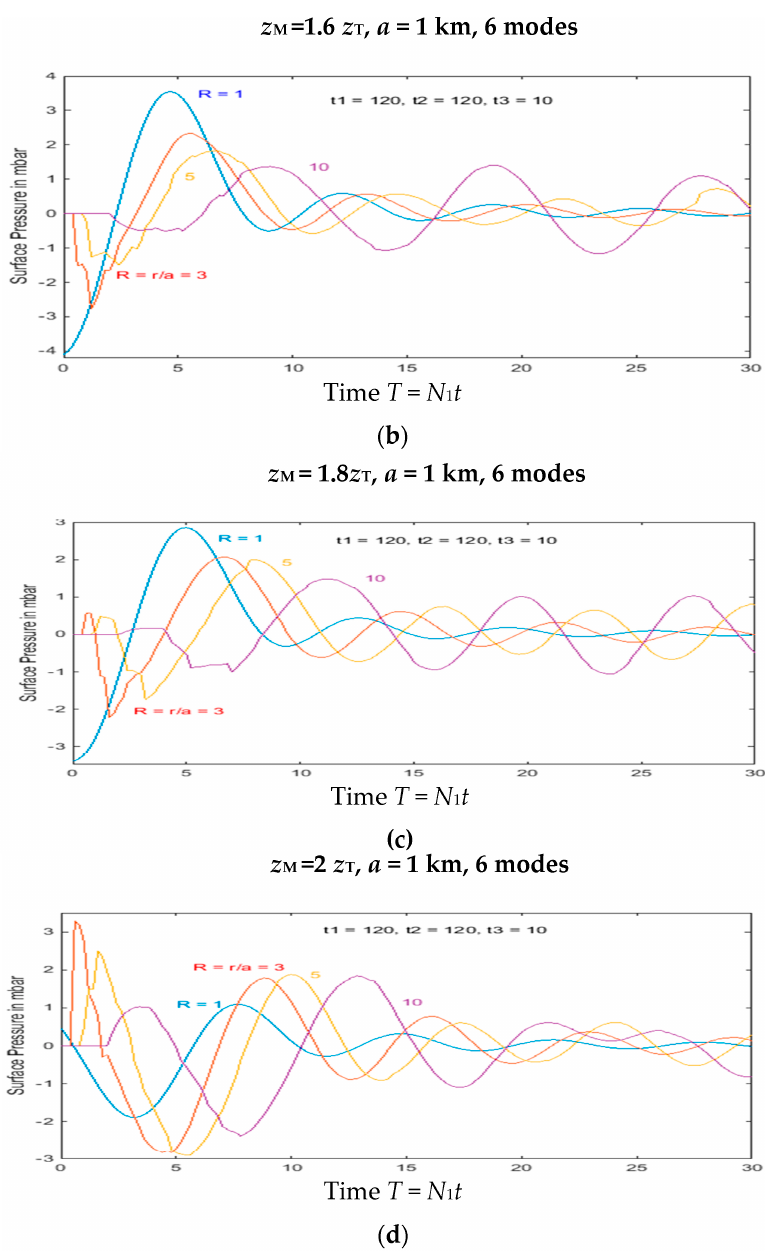
Figure 6. The time series of surface pressure signals in mb, forced at radius a = 1 km within the troposphere at distances R = r / a = 1, 3, 5, and 10 for eruptions that reach maximum heights z M where z M / z T equals: ( a ) 1.2; ( b ) 1.6; ( c ) 1.8; and ( d ) 2. Here, z T = 14 km, H s = 9 km, and h ( n ) coefficients are